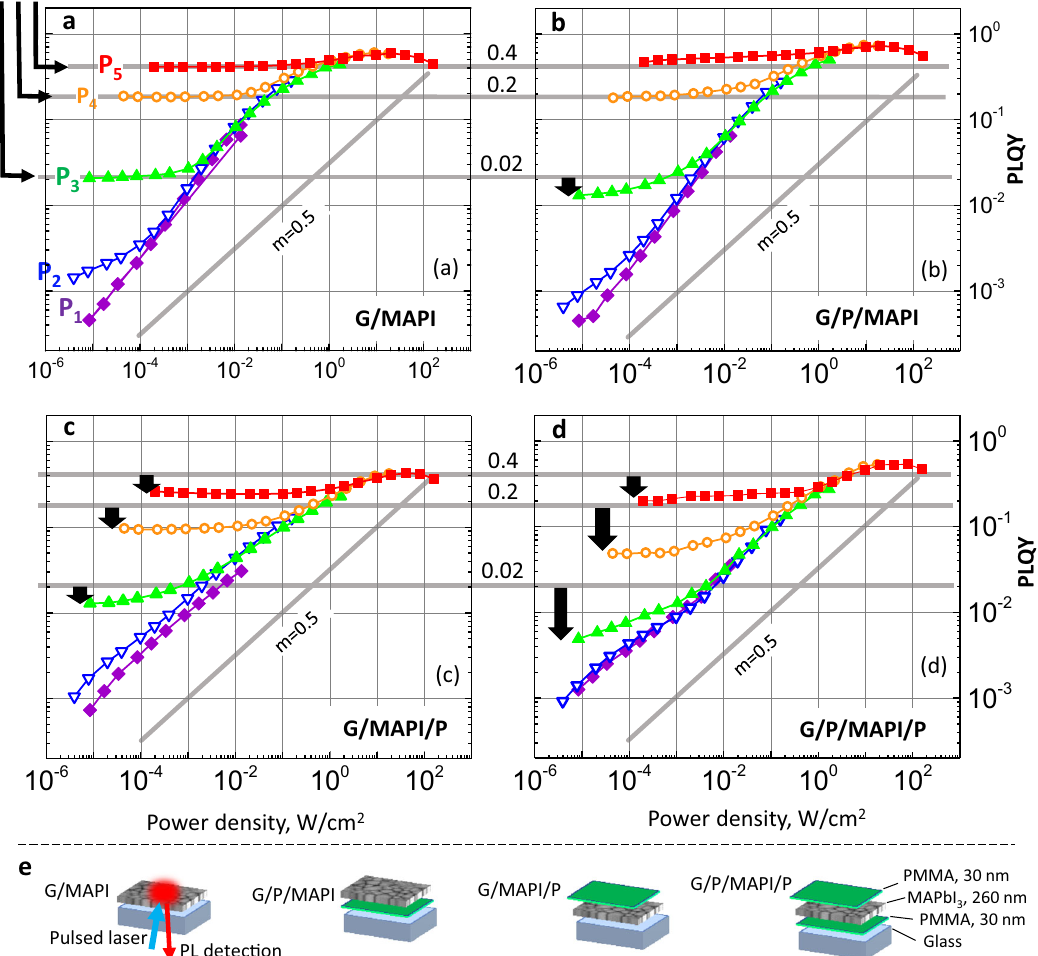
Fig. 2 PLQY maps of the samples under study plotted in the same scale for comparison. a Glass/MAPI, b glass/PMMA/MAPI, c glass/MAPI/PMMA, and d glass/PMMA/MAPI/PMMA. The horizontal grey lines show the values of PLQY (0.4, 0.2 and 0.02) in the single-pulse regime for the glass/MAPI sample ( a ) to set the benchmarks. Deviations from these values for other samples are shown by black arrows. The tilted grey line is the W 0.5 dependence as predicted by the SRH model. It is shown to see better the difference in the quasi-CW regime from sample to sample. The pulse fl uence ( P 1 – P 5) is indicated by the same colour code (shown in a ) for all PLQY maps. Panel e shows the structure of the samples and geometry of the